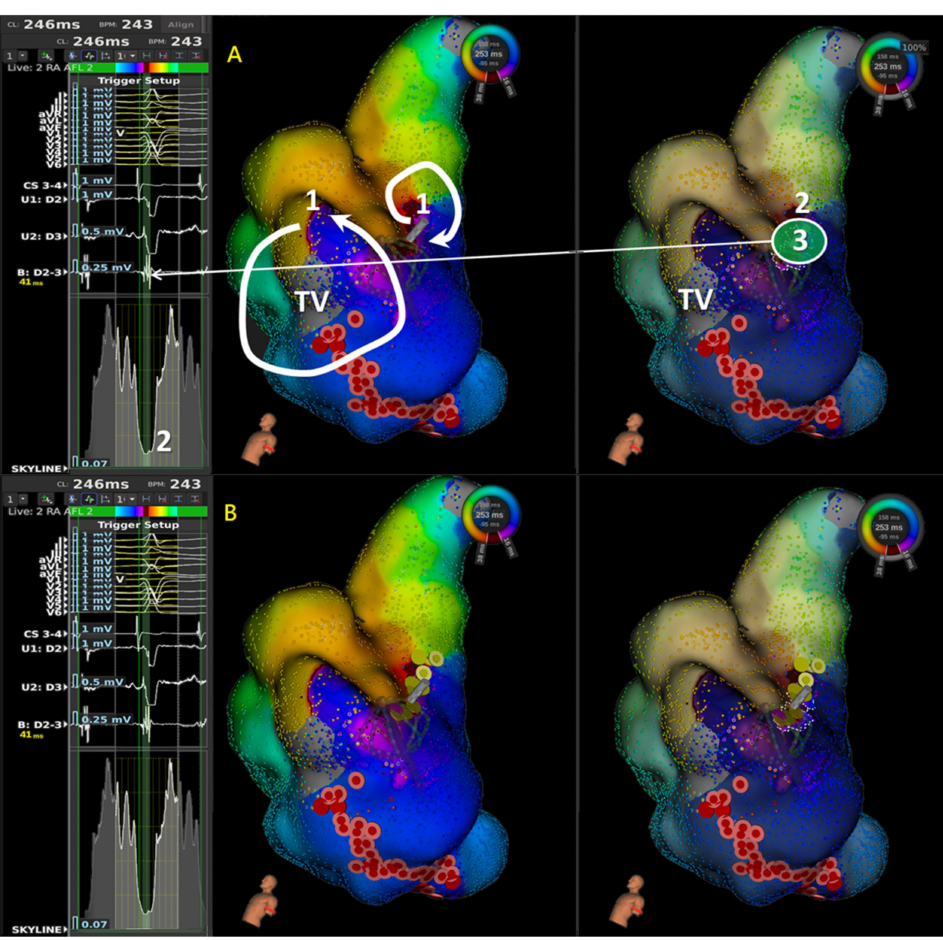
Figure 1. Illustration of stepwise approach in application of LUMIPOINT & Skyline for aAFL in a patient with prior cardiac surgery. In frame ( A ), 1 denotes first step to determine the possible main circuit in isochronal map; 2 denotes second step to scan the Skyline, identify the GAH-valley, and check the corresponding highlighted area in isochronal map; and 3 denotes third step to confirm the wave-front property and characteristics of local signals in highlighted area. In frame ( B ), ablation lesion set showed initial cavo-tricuspid isthmus (CTI) linear ablation failed to terminate the atrial flutter; instead, focal ablation at the highlighted area by Skyline valley successfully terminated atrial flutter to sinus rhythm (SR). In the first step, isochronal map showed two reentry circuits, one with macro-reentry counterclockwise atrial flutter and the other with localized reentry confined at mid-septum. Without entrainment, we cannot confirm the mechanism. Therefore, we started with CTI linear ablation instead of focal ablation because macro-reentry CTI dependent atrial flutter was more prevalent, and focal ablation in mid-septum took more risk in AV node injury. Since activation sequence and tachycardia cycle length did not change after CTI linear ablation, focal ablation in mid-septum terminated atrial flutter to SR. In this case, limitation of activation and isochronal map were seen and Skyline in LUMIPOINT feature adds its value and helped identify the slow conduction. (TV: Tricuspid